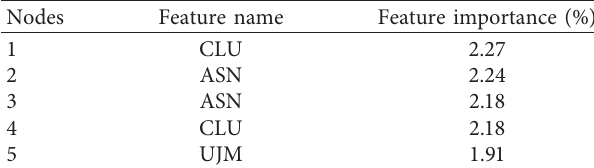
Table 6: Top five important features.